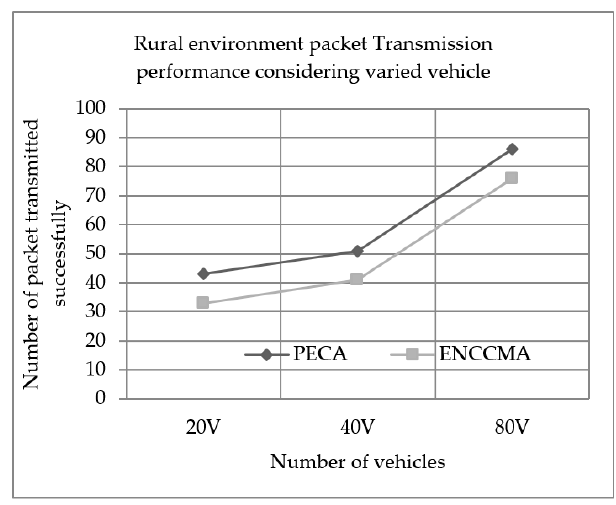
Figure 6. Rural environment packet Transmission performance considering varied vehicle.